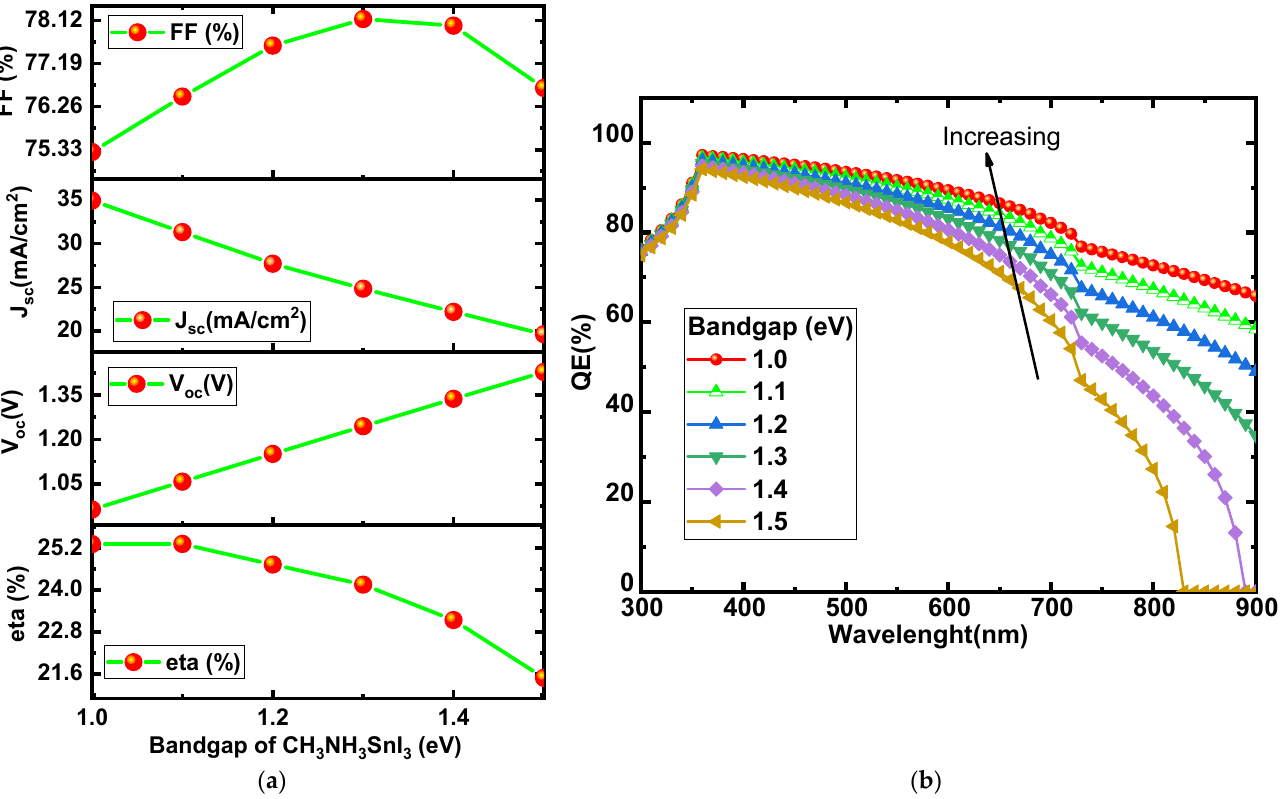
Figure 4. ( a ) Effect of bandgap of perovskite on solar cell parameters ( b ) QE vs.